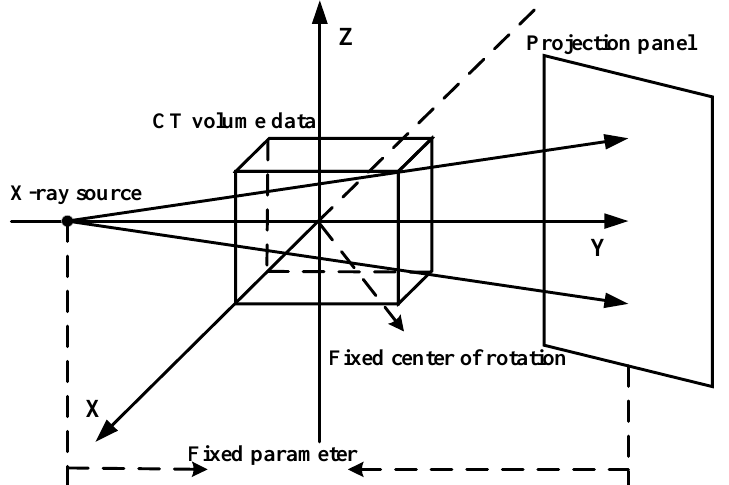
Figure 4. Schematic diagram of projection coordinate system.